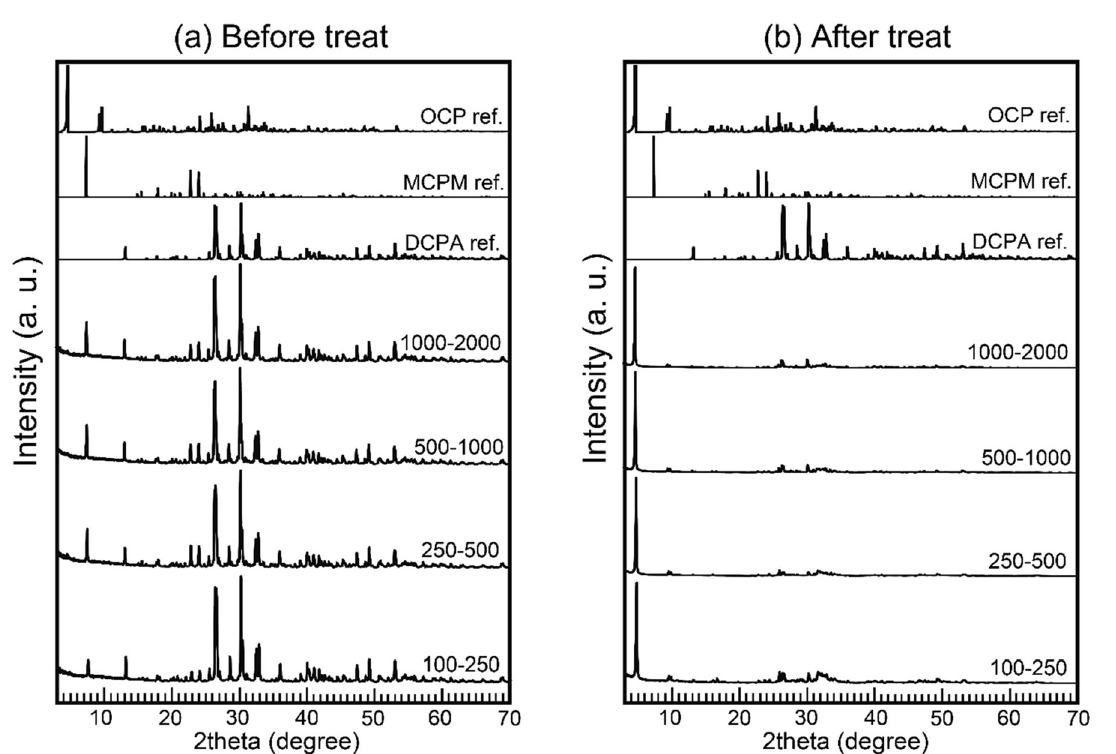
Fig. 3 XRD patterns of acidic calcium phosphate before ( a ) and after b immersion. DCPA, MCPM, and OCP reference patterns were included to facilitate comparisons